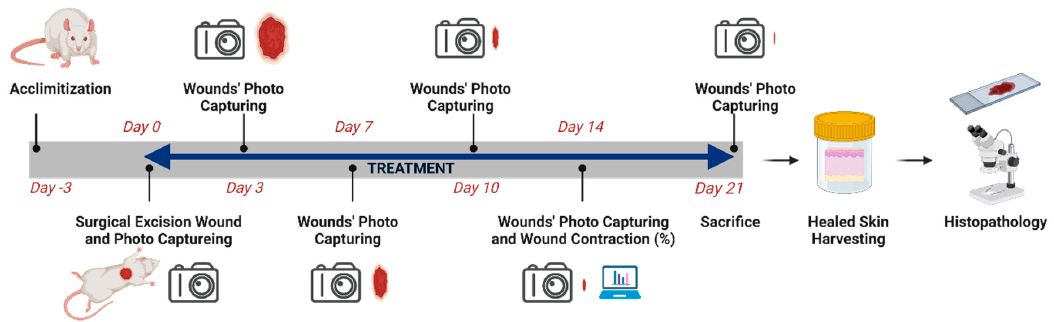
Figure 1. Schematic illustration of the experimental design.